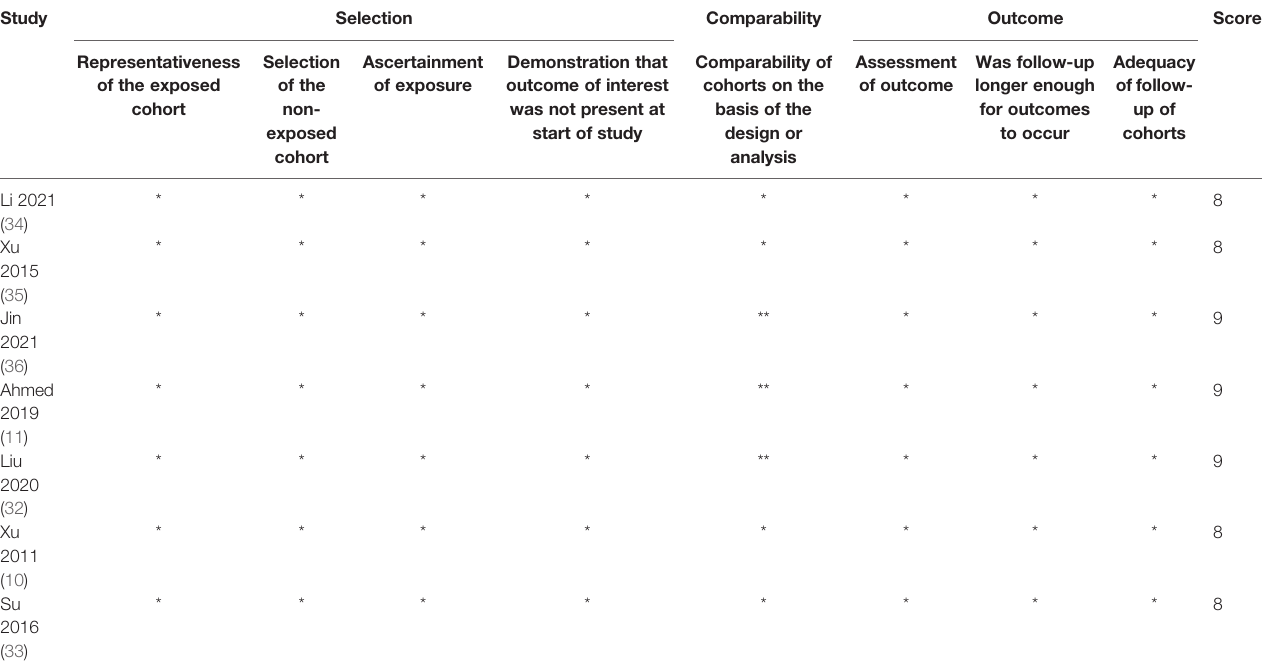
TABLE 2 | Assessment of quality of non-randomized studies. Study